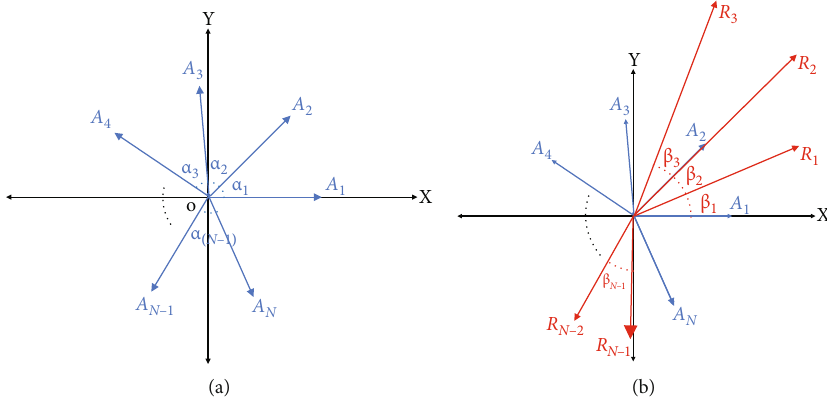
, A , A , ⋯ , A 1 2 3 N g with angular spacings f